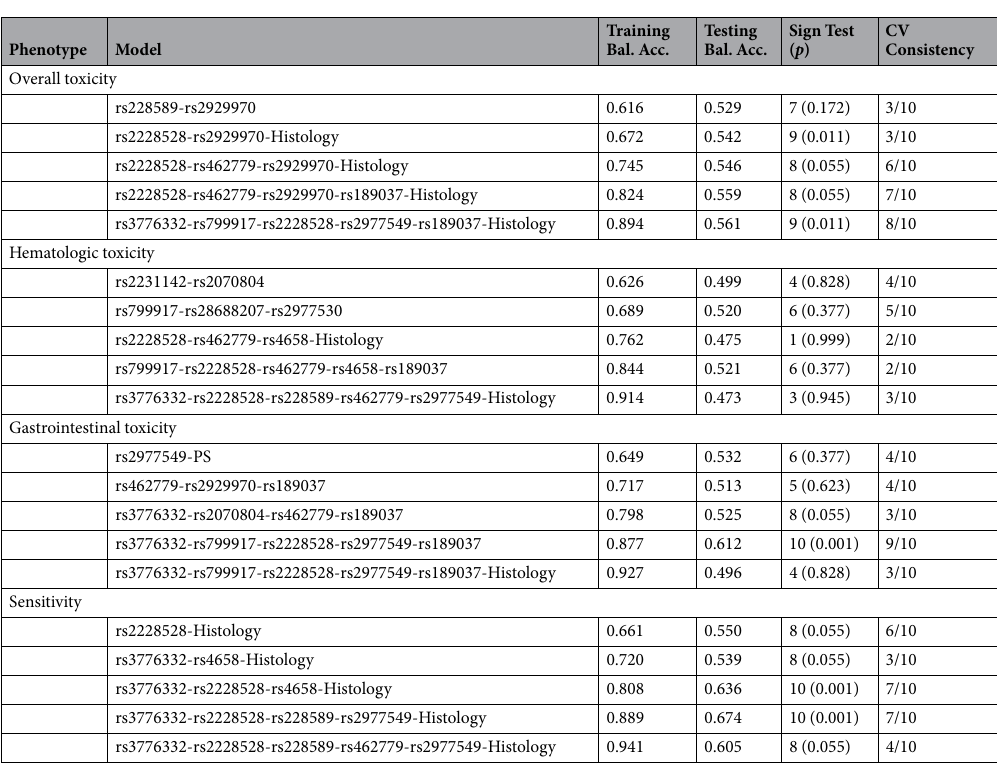
Table 3. Multi-dimensional gene-environment interaction in discovery